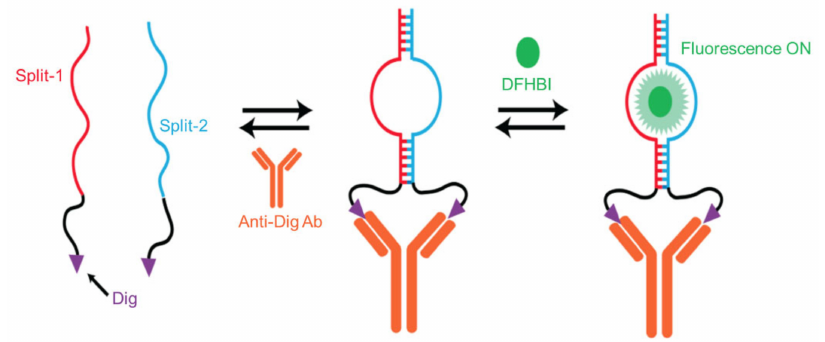
Figure 6. Conceptual scheme for a fluorogenic antibody sensor based on split green fluorescent protein (GFP)-mimic RNA aptamers and 3,5-difluoro-4-hyroxybenzylidene imidazoline (DFHBI). Adapted with permission from Anal. Chem. 2018, 90, 1049–1053, doi:10.1021/acs.analchem.7b02102. Copyright (2018) American Chemical Society